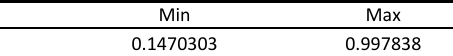
Table 2: Technical efficiency of the waste management agents Observation